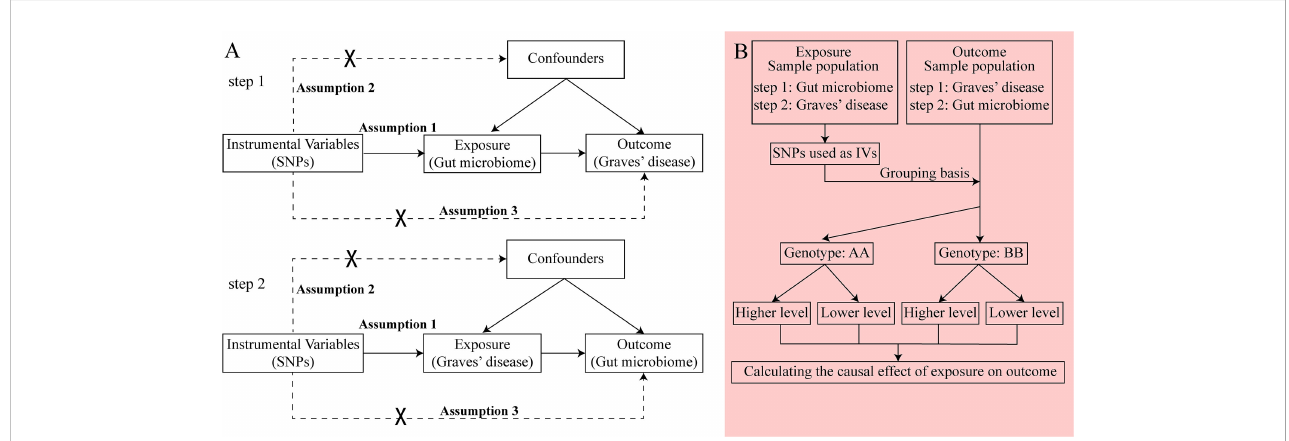
FIGURE 1 The principle of bidirectional Mendelian randomization (MR) analysis. The process of bidirectional MR analysis was divided into two steps. Each step contained three assumptions (assumptions 1, 2, and 3) and involved a two-sample MR analysis to detect the causal effect between exposure and outcome (A) . The idea of a two-sample MR analysis was represented by a fl owchart (B) . In step 1, the gut microbiome served as exposure, and Graves ’ disease (GD) served as the outcome. The single nucleotide polymorphisms (SNPs) obtained from the gut microbiome were considered instrumental variables (IVs), which provided the grouping basis for the GD sample population. The effect of every SNP was combined and the causal effect of gut microbiome on GD was calculated through MR analysis. In step 2, the GD served as exposure, and the gut microbiome served as the outcome. The SNPs obtained from GD were considered IVs, which provided the grouping basis for the gut microbiome sample population. The effect of every SNP was combined, and the causal effect of GD on the gut microbiome was calculated through MR analysis. GD, Graves ’ disease; IV, instrumental variable; SNP, single nucleotide